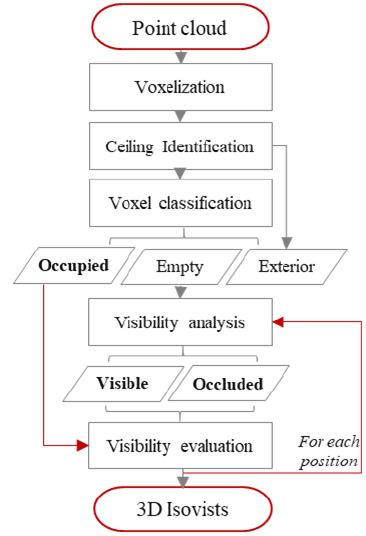
Figure 1. Workflow of the proposed